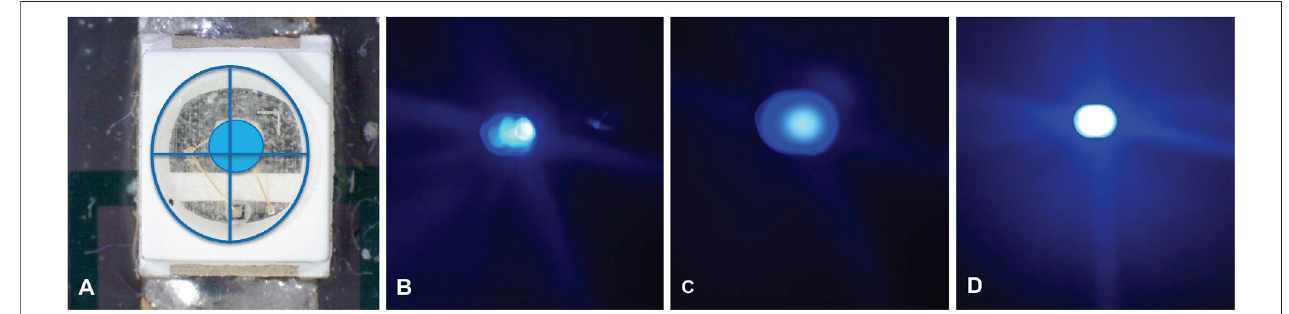
FIGURE 2 | Images showing (A) : Off-centred surface mount LED. Comparison of light dispersion using the SM LED 1.75 × 1.0 mm elliptical photomask and (B) : one-layer PMMA diffuser, (C) : two-layer PMMA diffuser and (D) : three-layer PMMA diffuser.